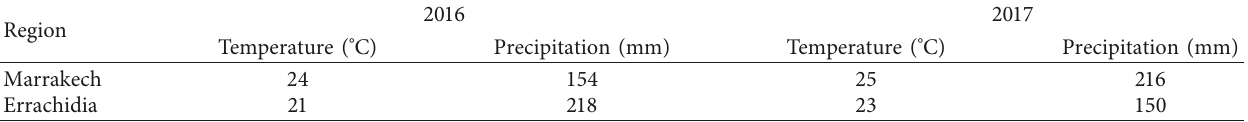
Table 2: Temperature and precipitation of Marrakech and Errachidia during 2016 and 2017 crop